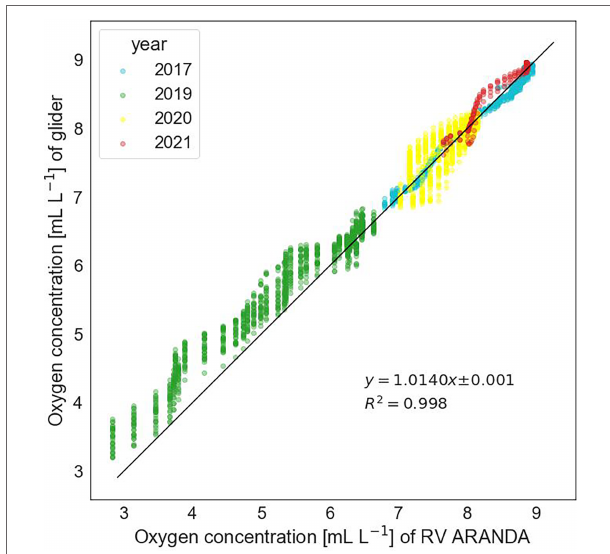
FIGURE 4 | Observed oxygen concentrations (mL L -1 , left), expected oxygen saturation (mL L -1 , middle), and observed percent oxygen